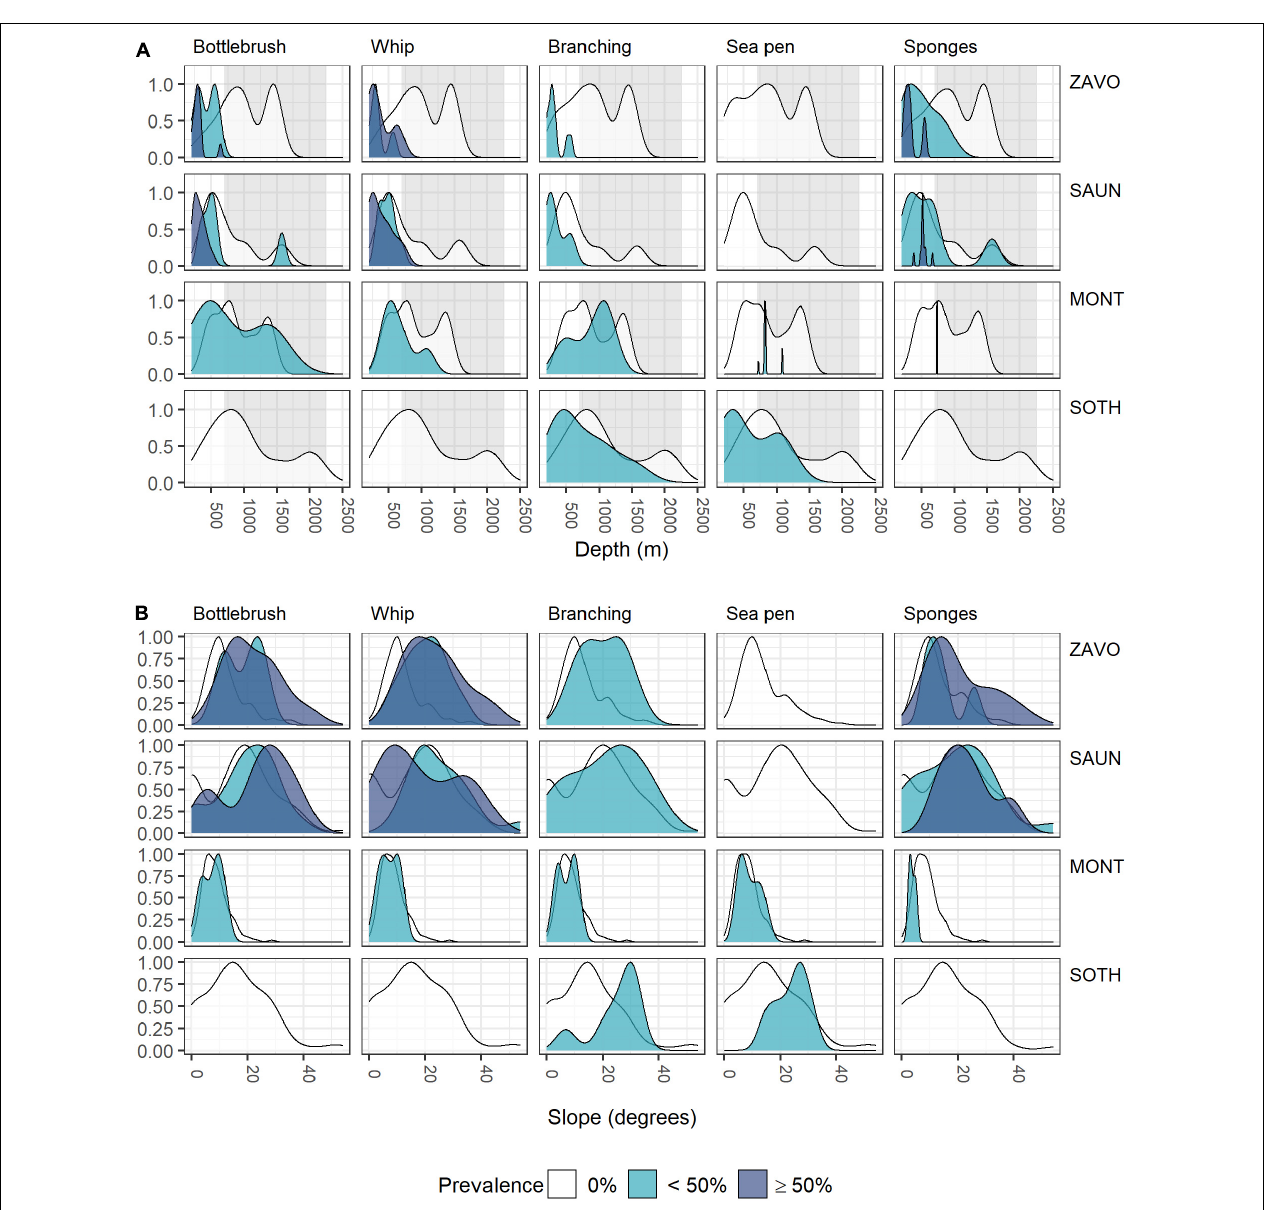
FIGURE 5 | Scaled density curves showing the frequency of OBIA objects with 0, < 50, or ≥ 50% prevalence of VME indicator taxa in intersecting images across the range of (A) depth, (B)